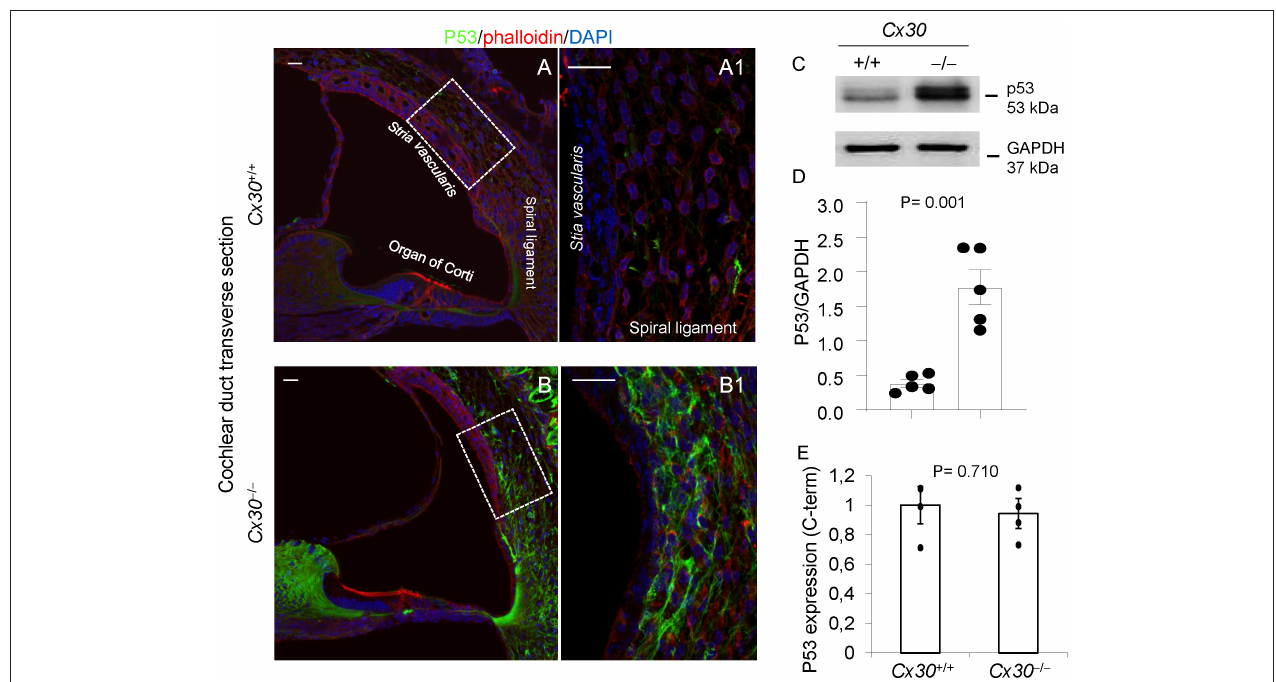
FIGURE 4 | p53 expression in Cx30 + / + and Cx30 − / − cochleae at P5. (A,B) p53 immunoreactivity in the cochlear duct (A,B) and lateral wall (shown magnified in A1,B1 ) of Cx30 + / + and Cx30 − / − cochleae at P5. Scale bars: 20 µ m. (C) Representative western blot immunoreactive bands quantifying the expression of p53 in